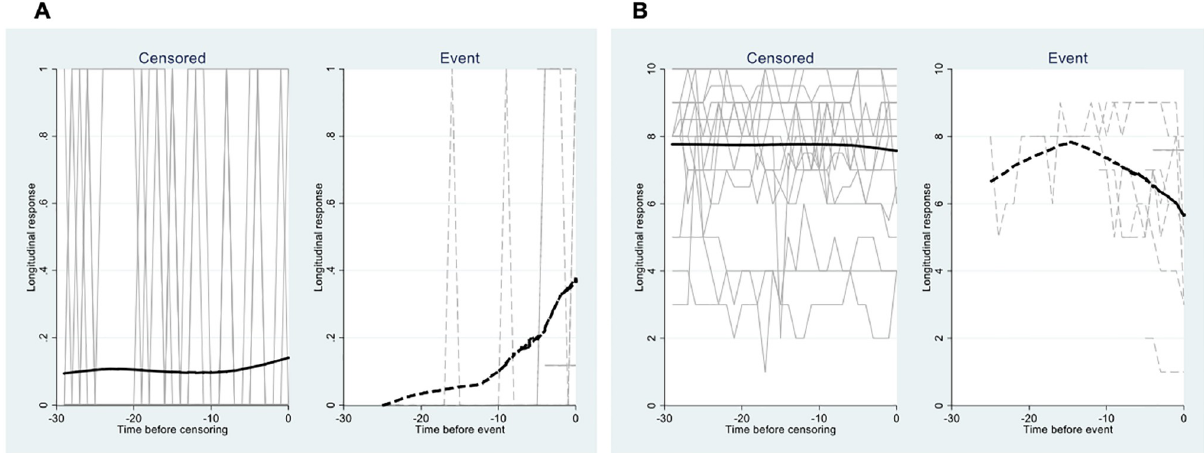
Fig 1. Longitudinal trajectory plots for Q1 (A: Struggling to breath) and Q13 (B: How do you feel in general?). Time scale adjusted by subtracting patient’s time to readmission/censoring (0 indicates point of readmission or censoring). Q1 shows an exponential increase in struggling to breath as time to readmission draws closer. Q13 shows a linear decrease in how patients feel about 2 weeks before time to readmission. There was virtually no change for patients not readmitted (censored) for either question.